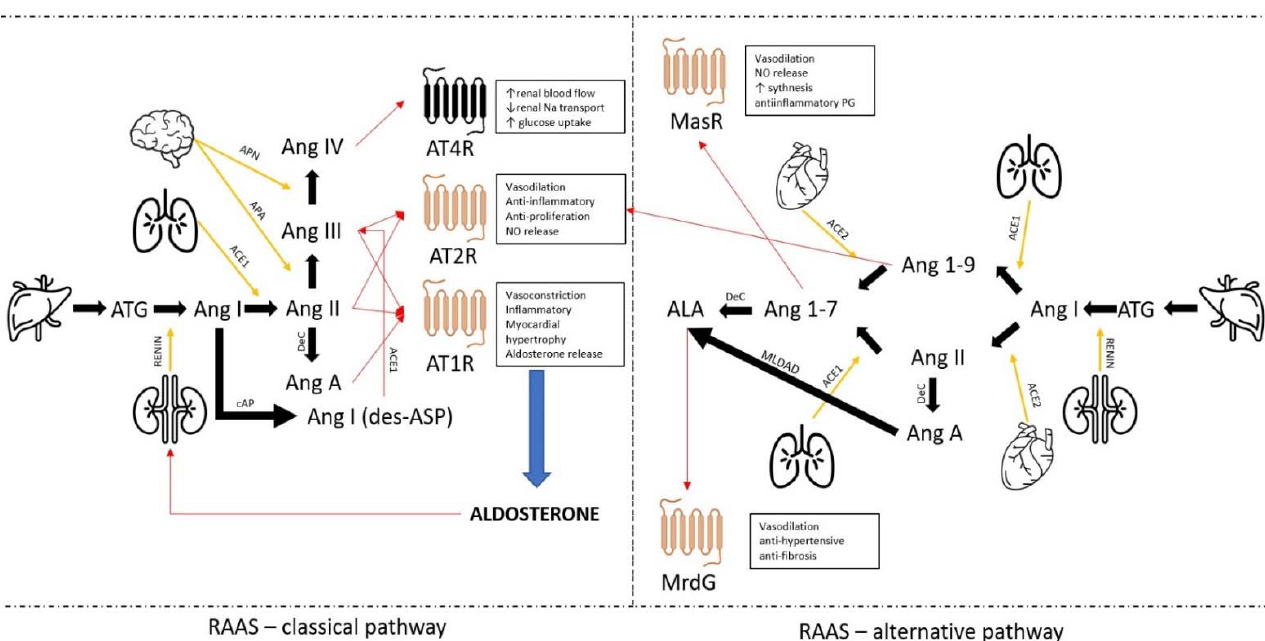
Figure 1. Scheme of the classical and alternative pathways of RAAS . Orange receptors represent a G-protein coupled receptor family, black receptors represent an insulin-regulated membrane aminopeptidase. Yellow arrows represented a tissue-specific enzyme, and red arrows represented the direction of peptide actions. ATG—angiotensinogen; Ang I—angiotensin